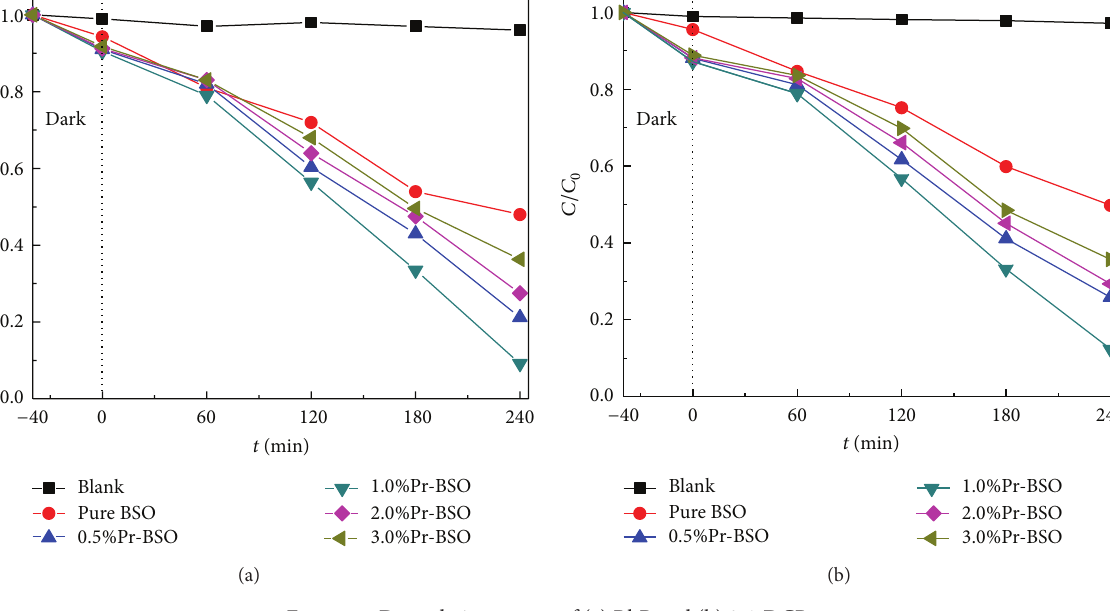
Figure 7: Degradation curves of (a) RhB and (b)